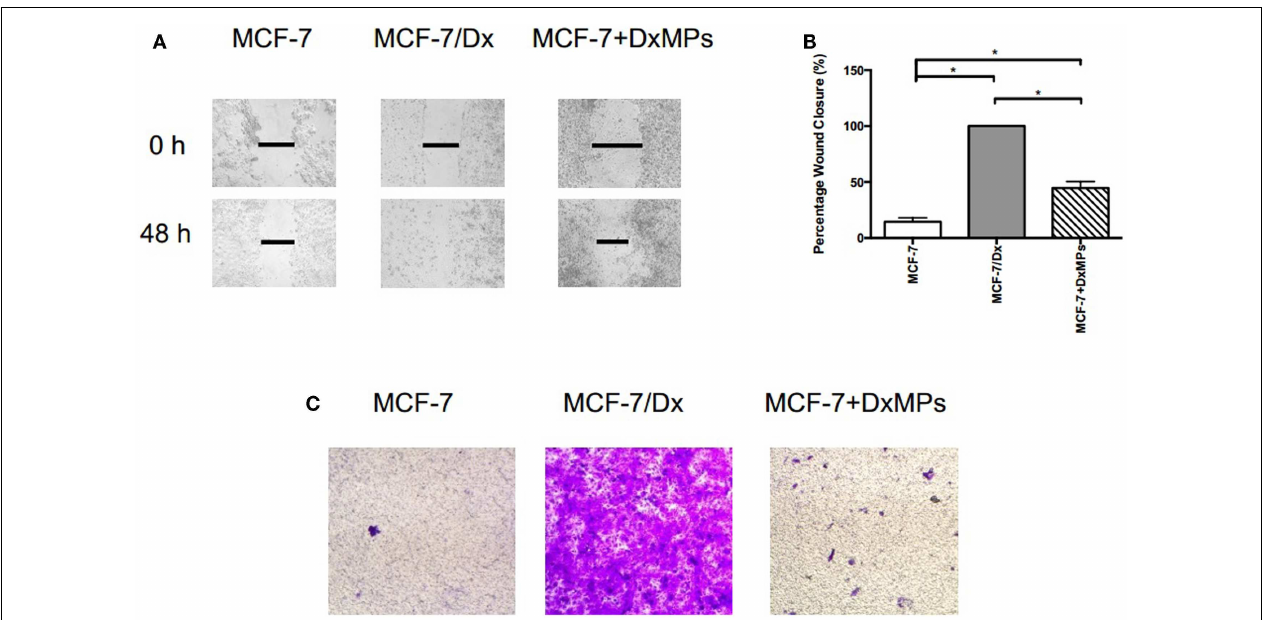
wound closure observed in ( ): MCF-7 cells, ( ): MCF-7/Dx cells, and ( ): MCF-7 cells co-cultured with DxMPs. Data represent the mean ± SEM of at least three independent experiments. * p < 0.05. (C) Invasive capacity of breast cancer cells.Transwell insert invasion by MCF-7 cells, MCF-7/Dx cells, and MCF-7 cells co-cultured with DxMPs. Invasion of cells through a Matrigel ® layer to the underside of transwell membranes was assessed after 48h. Data was representative of at least three independent